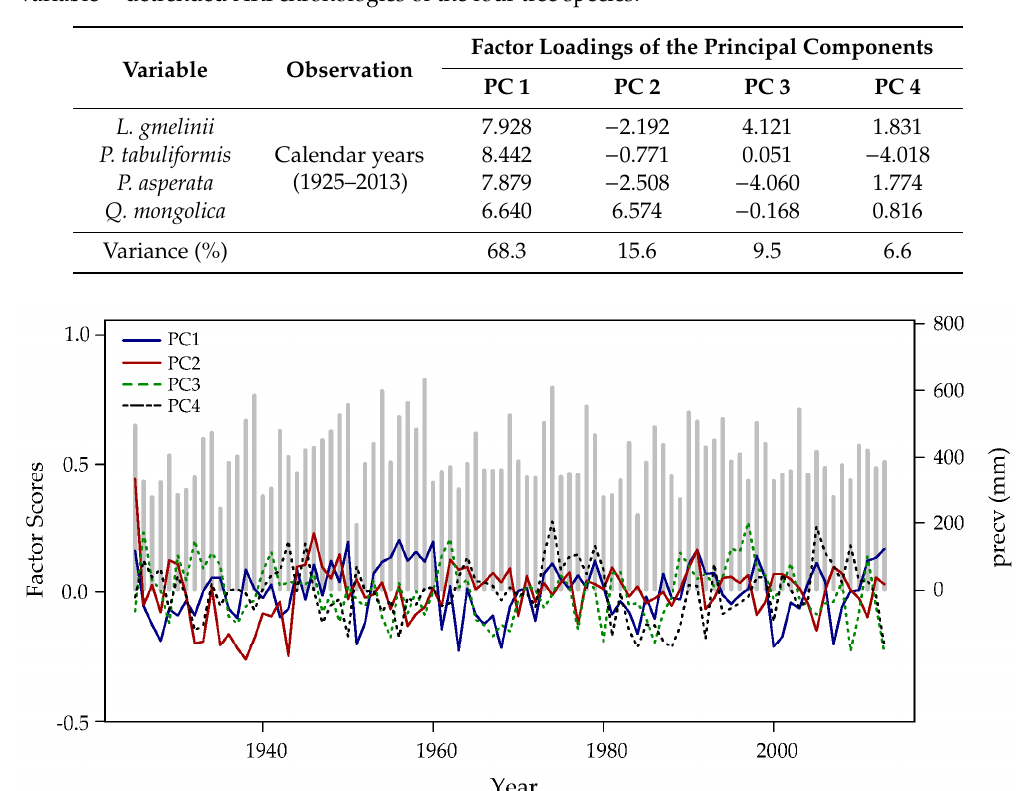
Table A2. Summary statistics of the Principal Components Analysis (PCA)-matrix of factor loadings. Variable = detrended ARI chronologies of the four tree species.